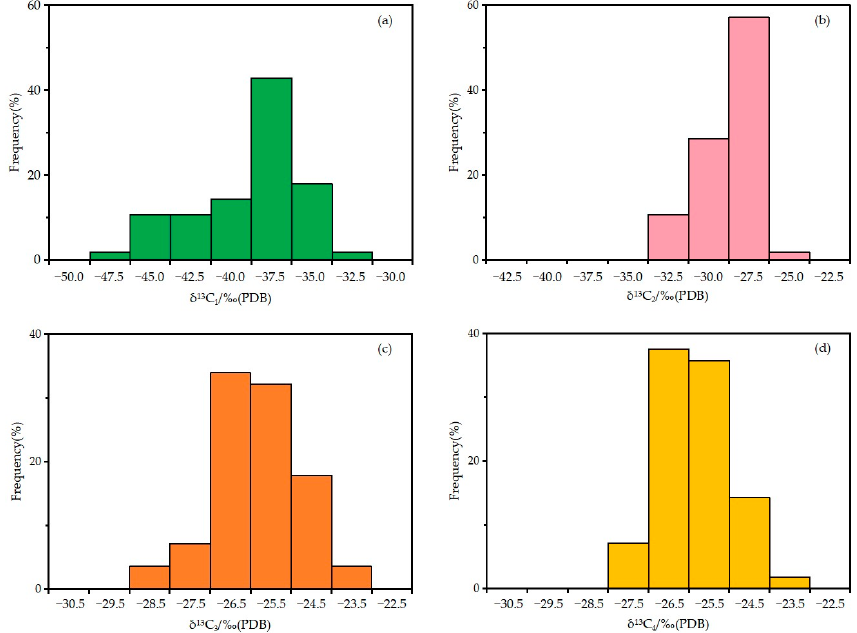
Figure 2. Histogram of δ 13 C 1 ( a ), δ 13 C 2 ( b ), δ 13 C 3 ( c ), and δ 13 C 4 ( d ) of the natural gas in the eastern belt around the Penyijingxi sag, Junggar Basin.